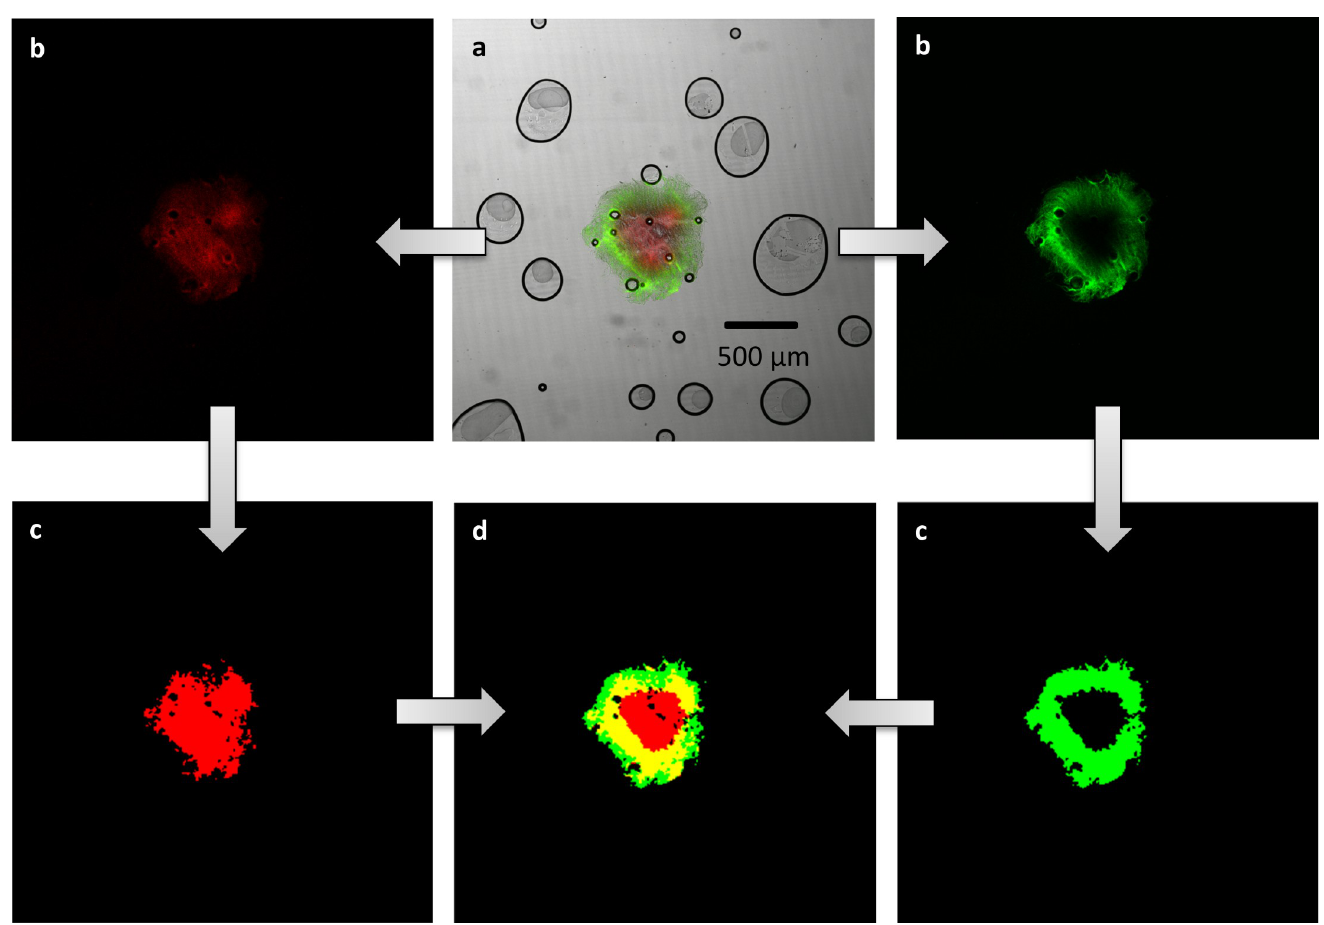
Fig 1. Processing scheme for the image analysis of stained pellet slices: (a) original CLSM image with green and red fluorescent areas (black circles are air bubbles that are occasionally enclosed in the sectioning medium), (b) separation in green fluorescence and red fluorescence, (c) images after binarization and closing and (d) combination to one image with living (green), dead (red) or living and dead pellet areas (yellow).